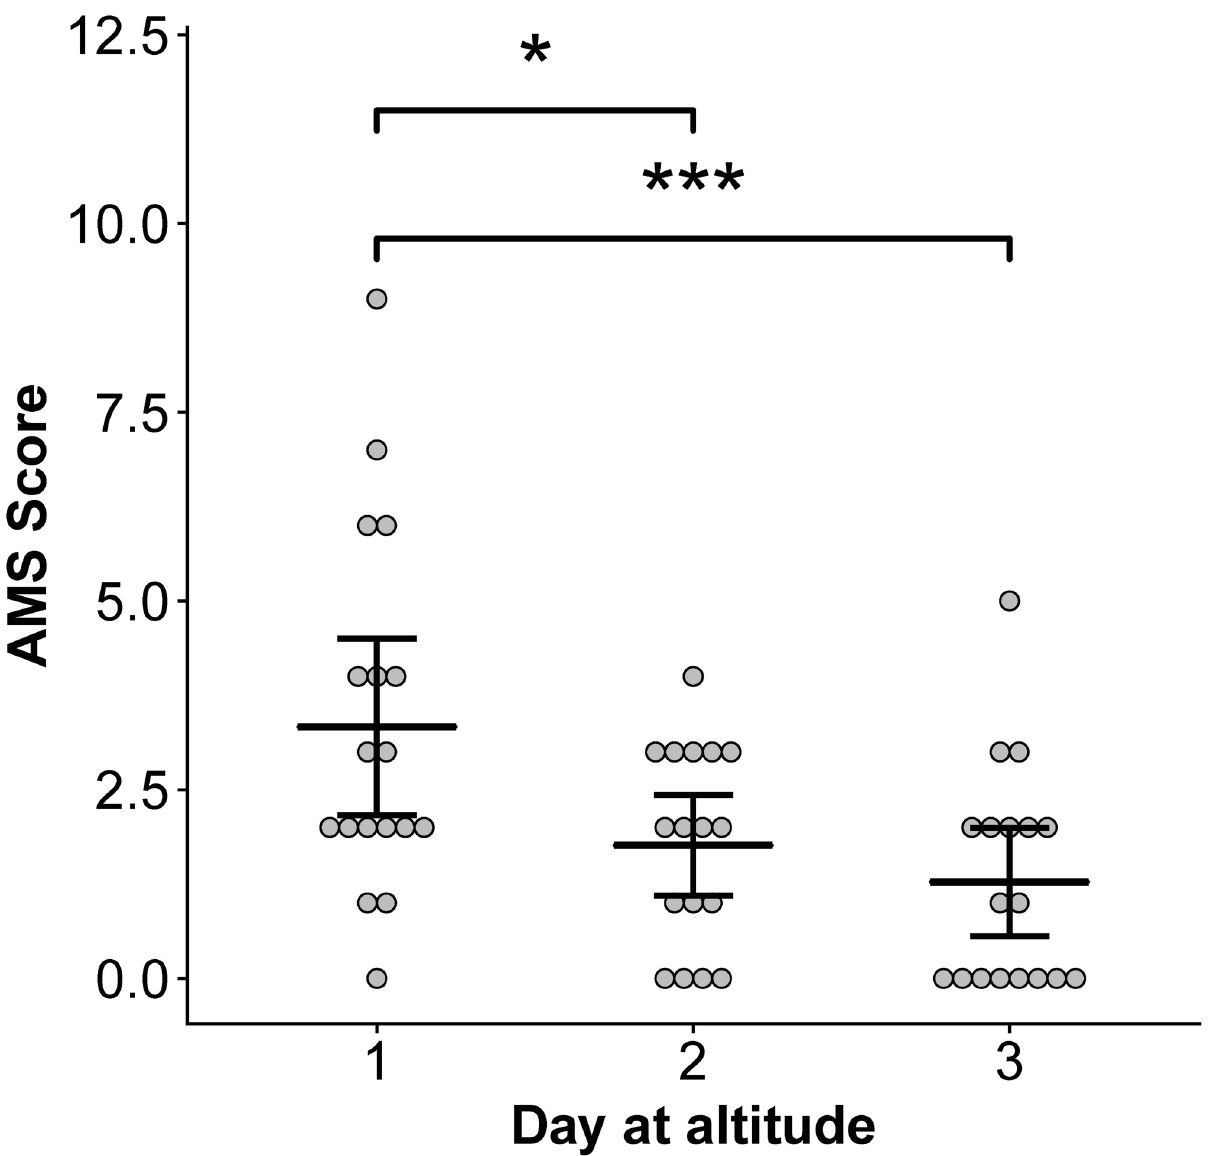
Fig 1. AMS scores decrease over three days at high-altitude. Points indicate daily AMS scores for each individual. Means and 95% confidence intervals are provided for each day. Asterisks indicate significant differences across days at p < 0.05 ( � ) and < 0.001 ( ��� ). A score of 3–5 indicates mild AMS and � 6 indicates severe